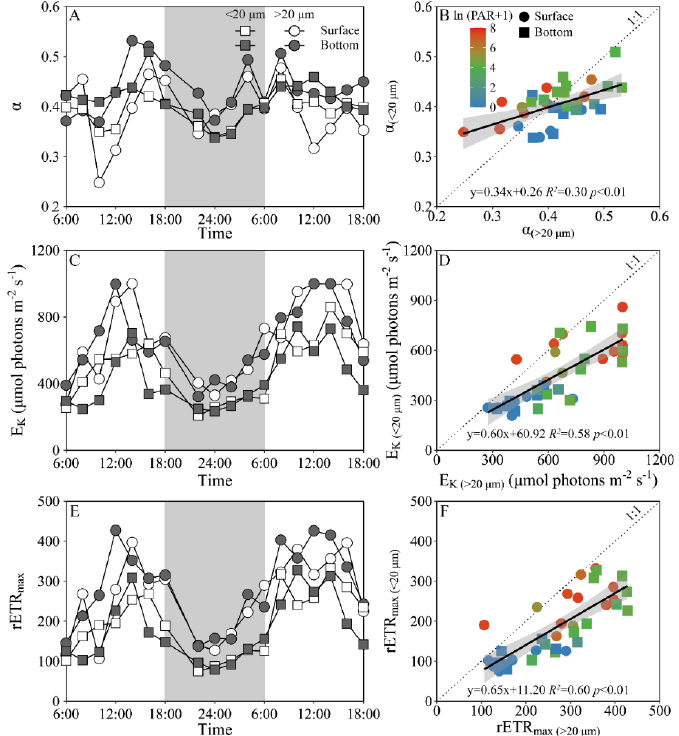
Figure 4. Daily changes in the maximum photochemical quantum yield ( A , F V /F M ) of Photosystem II (PSII) and absorption cross section for PSII photochemistry ( C , σ PSII , nm 2 ) of piconano- (<20 µm) and micro-cell assemblies (>20 µm) in surface and bottom layers of experimental site, as well as the comparisons of ( B ) F V /F M or ( D ) σ PS II between piconano- and micro-cell assemblies. Grey shadows in panels A and C indicate the nighttime. Solid lines in panels B and D show the linear regression with shadow indicating 95% confidence interval; and the color in symbol indicates the ln(PAR + 1) wherein the PAR is the cell-received irradiance in field condition.